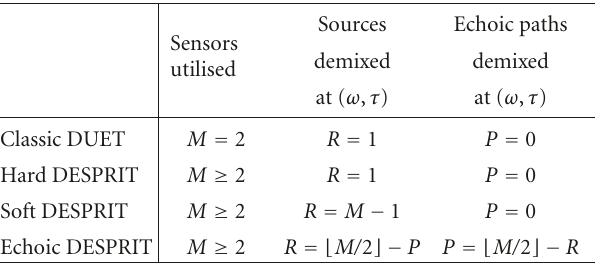
Table 1: Summary of the properties of the three extensions to DUET, where the number of echoic paths is the number of extra (nondirect)